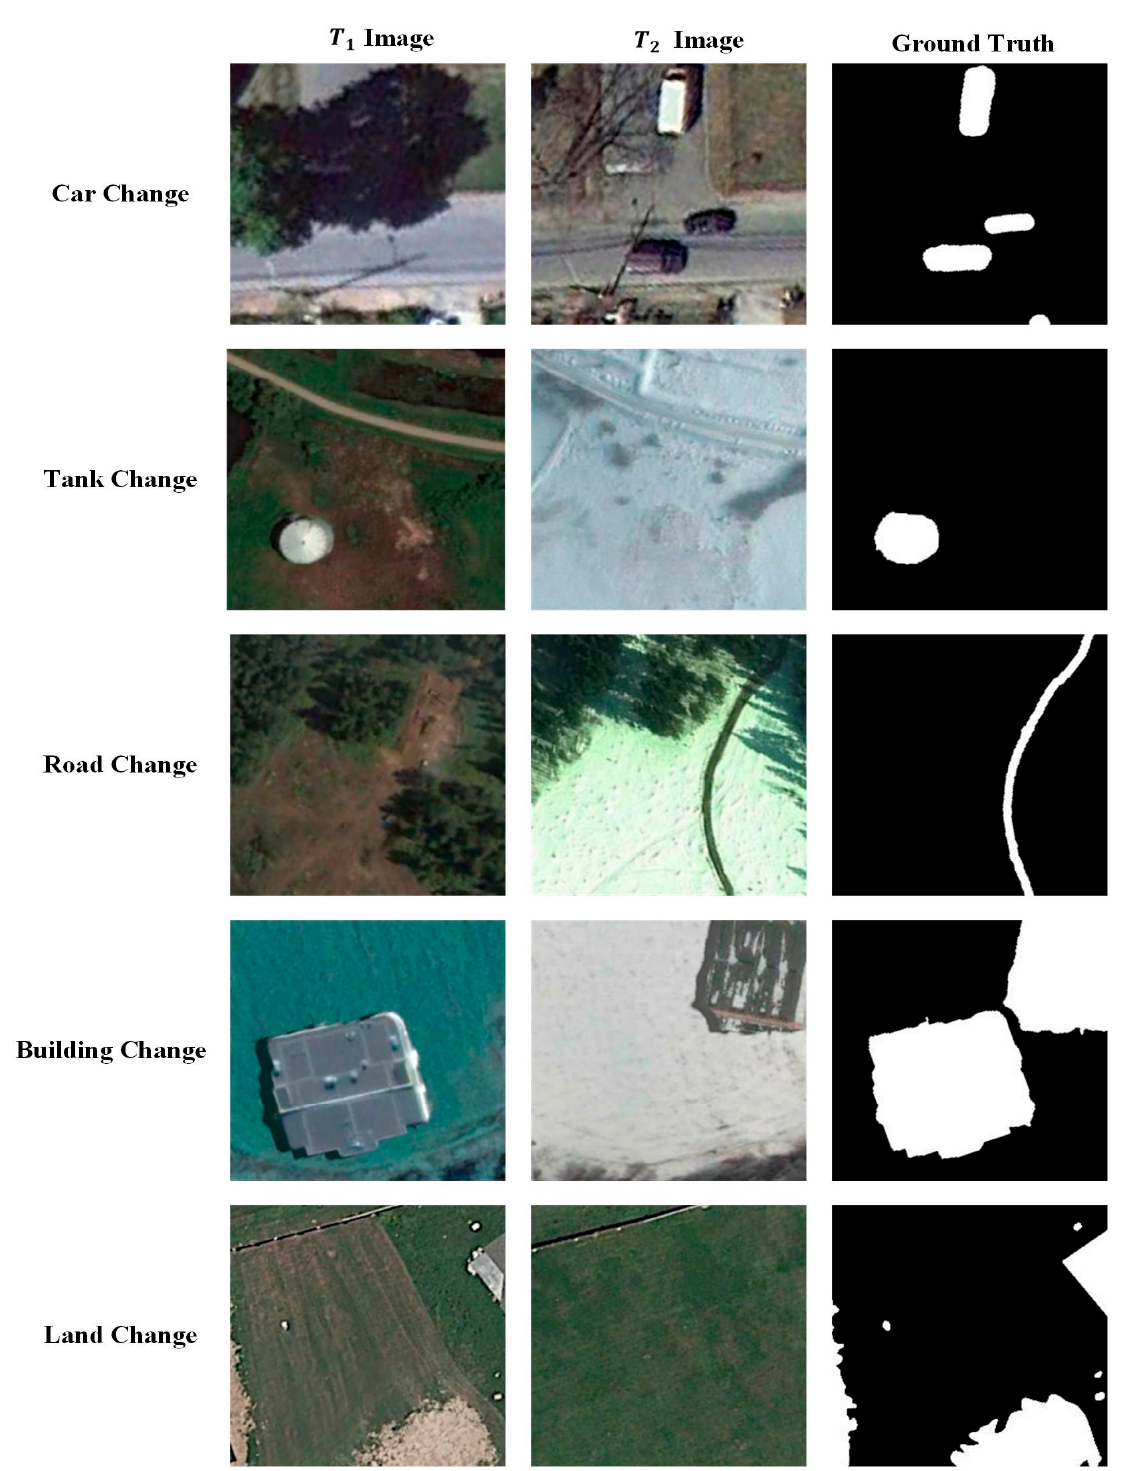
Figure 3. An illustration of different object changes.